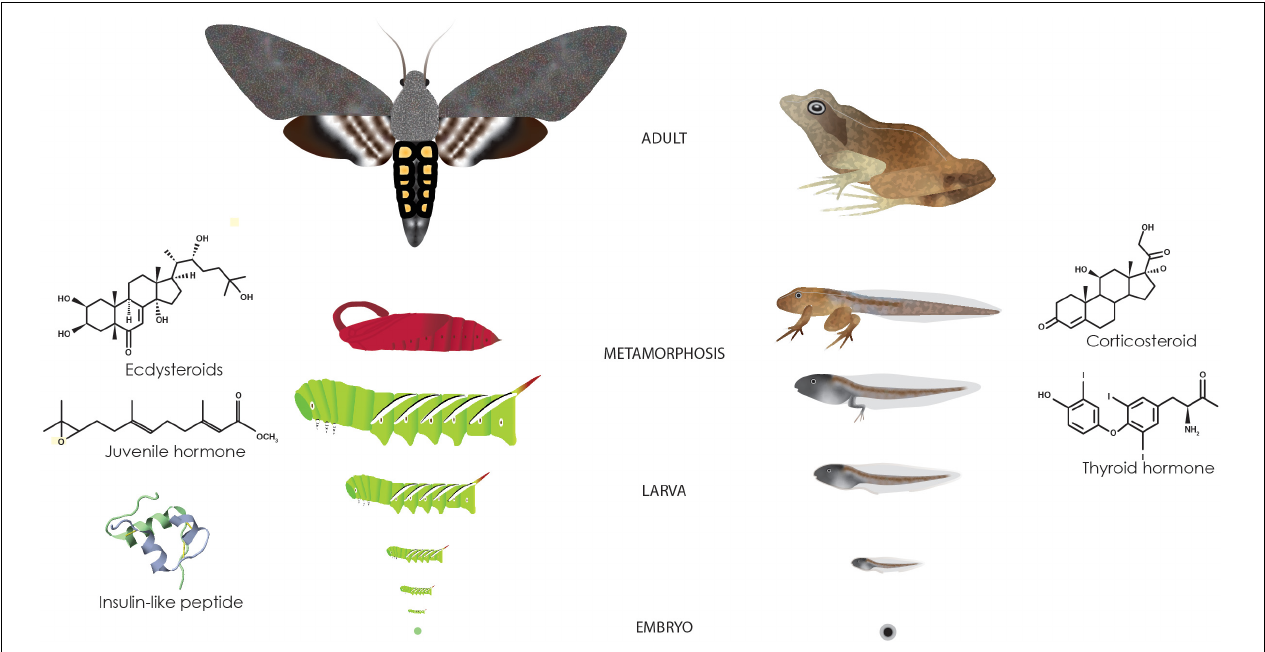
FIGURE 1 | Metamorphosis in insects and vertebrates. Holometabolous insects and anurans grow as a larva and undergoes metamorphosis before developing into an adult. Major hormones involved in this process are depicted next to the drawings. Insulin-like peptide is Dilp5 from Drosophila (generated using FirstGlance in Jmol at